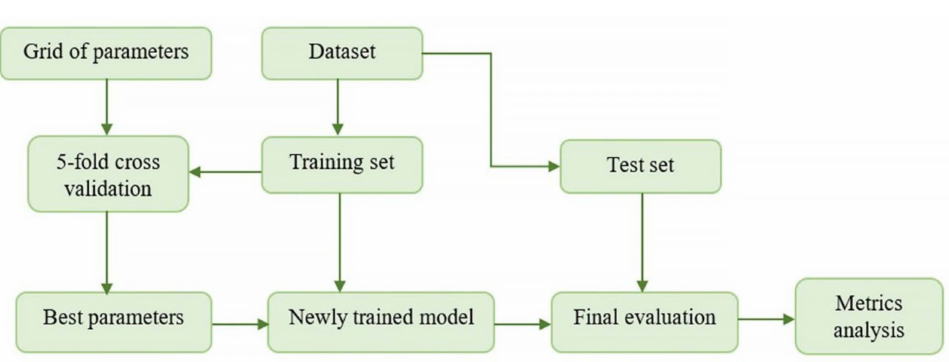
Figure 4. Parameter selection and model evaluation process using parameter grid and five-box